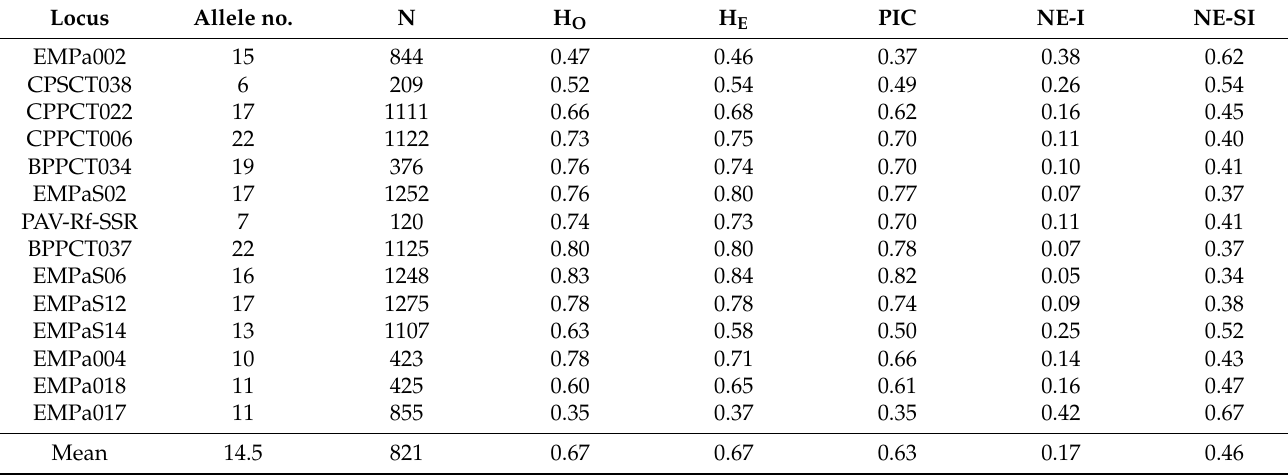
Table 3. Summary statistics from allele frequency analysis of unique diploid samples after alignment. Locus Allele no.